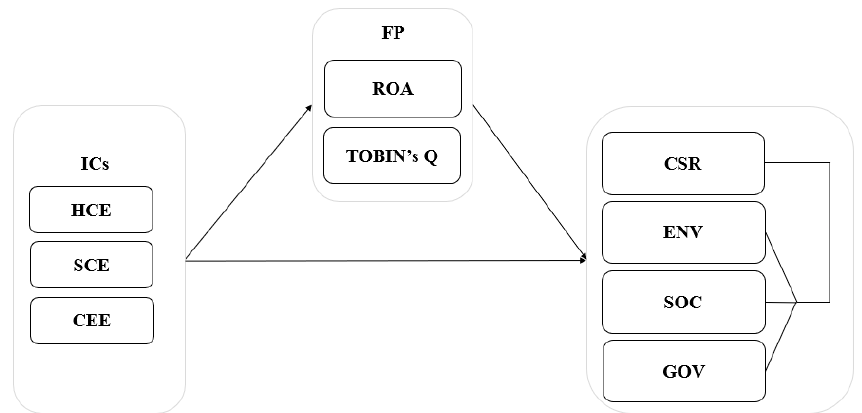
Figure 1. Research framework. Abbreviations: ICs: intellectual capital components; HCE: human capital efficiency; SCE: structural capital efficiency; CEE: capital employed efficiency; FP: financial performance; ROA: return on assets; CSR: corporate social responsibility; ENV: environmental; SOC: social; GOV: governance.